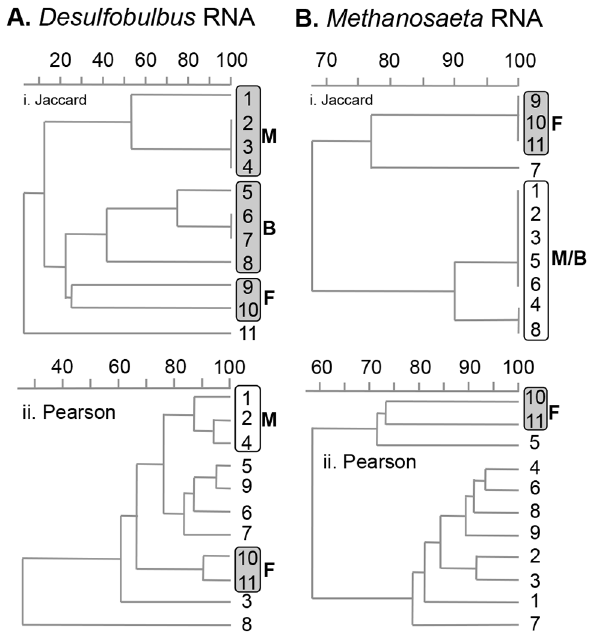
Figure 3. Cluster analyses of the RNA-DGGE profiles: i. Jaccard and ii. Pearson analyses of A. Desulfobulbus ; B. Methanosarcina . Marine (M), Marine/Brackish (M/B), Brackish (B), Freshwater/Brackish (F/ B) and Freshwater (F) clusters are circled. Shaded clusters are geographically continuous, unshaded clusters are not.